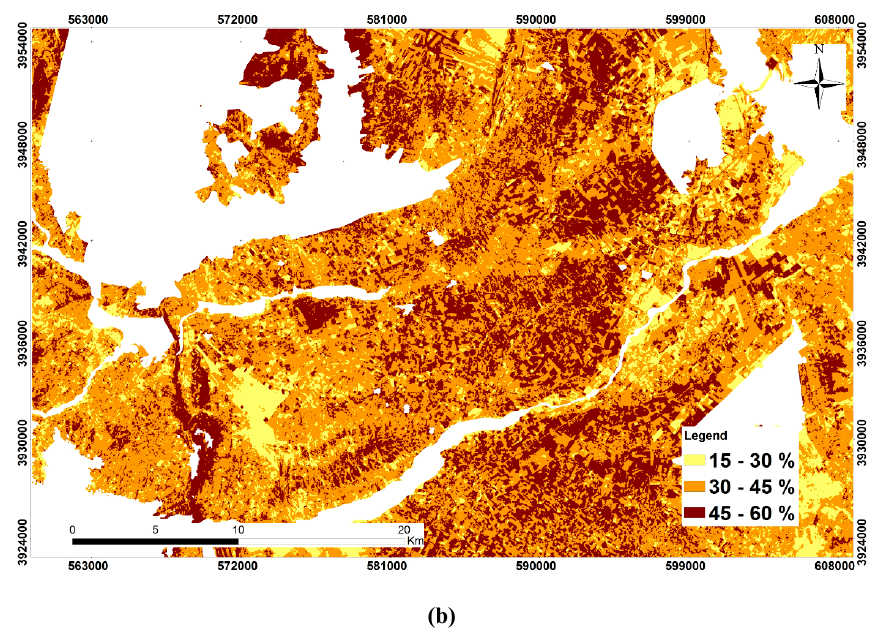
Figure 10. Clay maps using soil moisture products, using: ( a ) the SVM classifier; ( b ) the RF classifier.